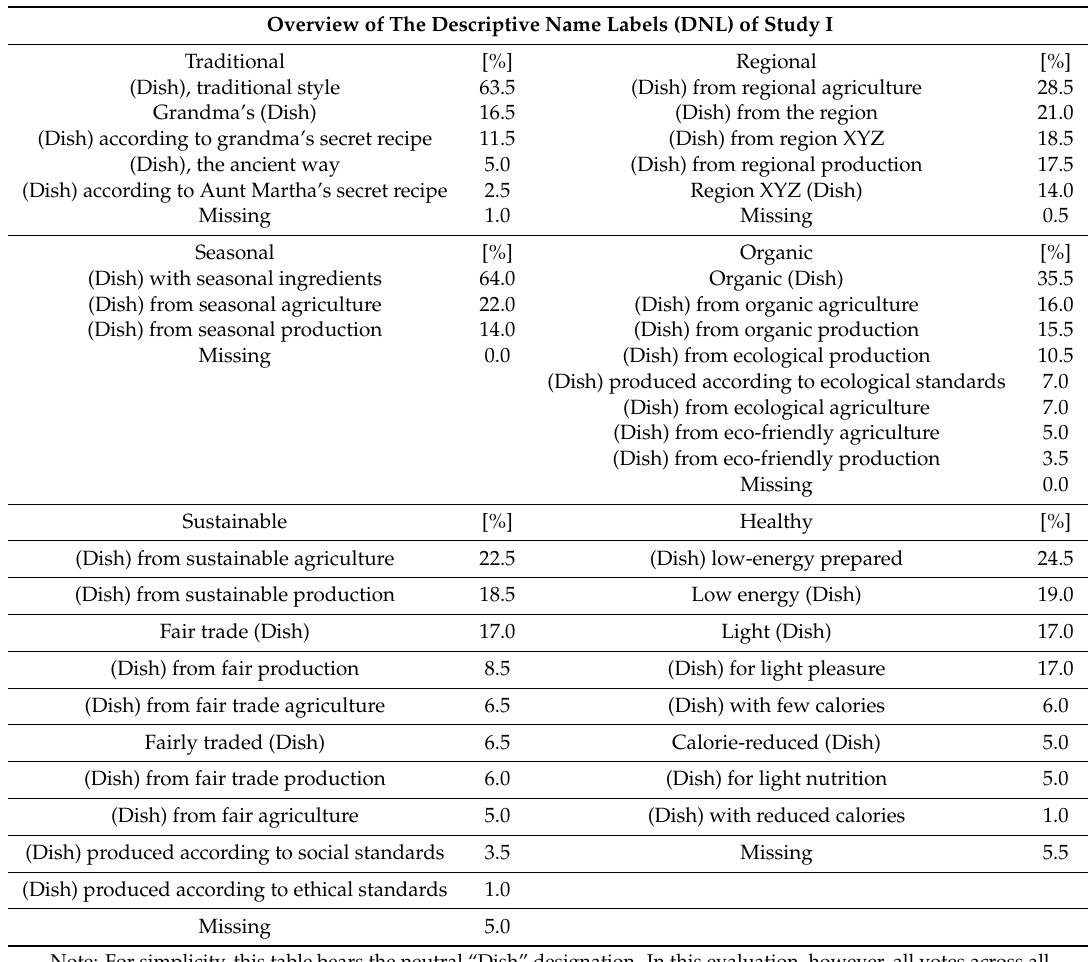
Table 4. Overview of the pre-tested descriptive name labels (DNL) of Study I ( n = 100). Overview of The Descriptive Name Labels (DNL) of Study